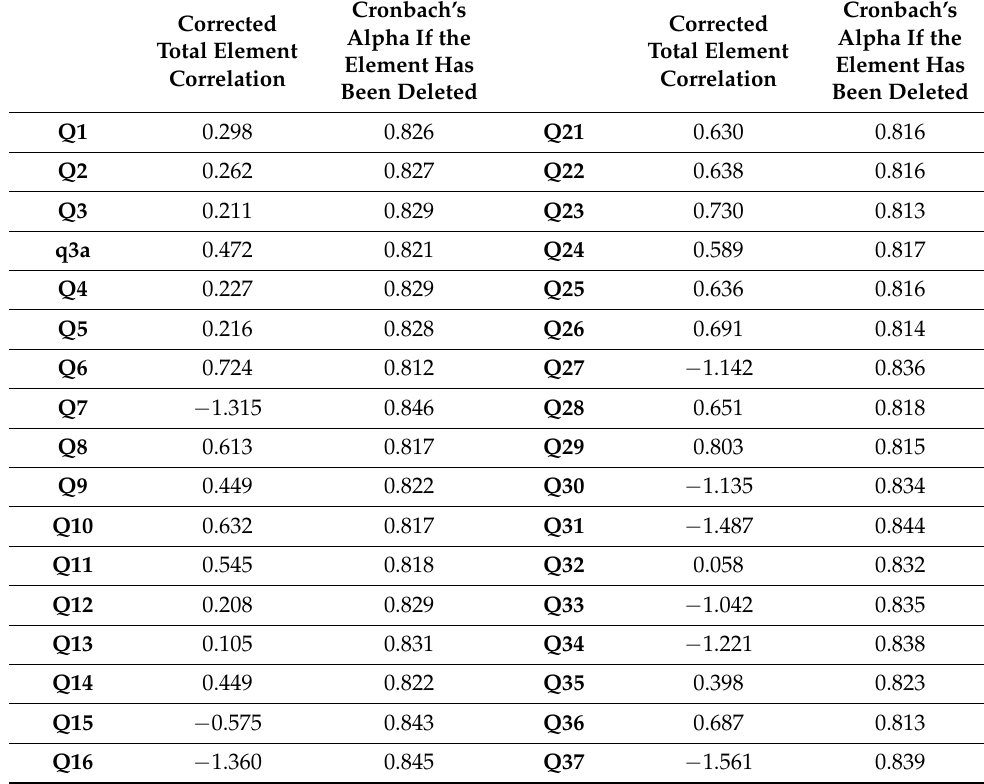
Table 8. Consistency of